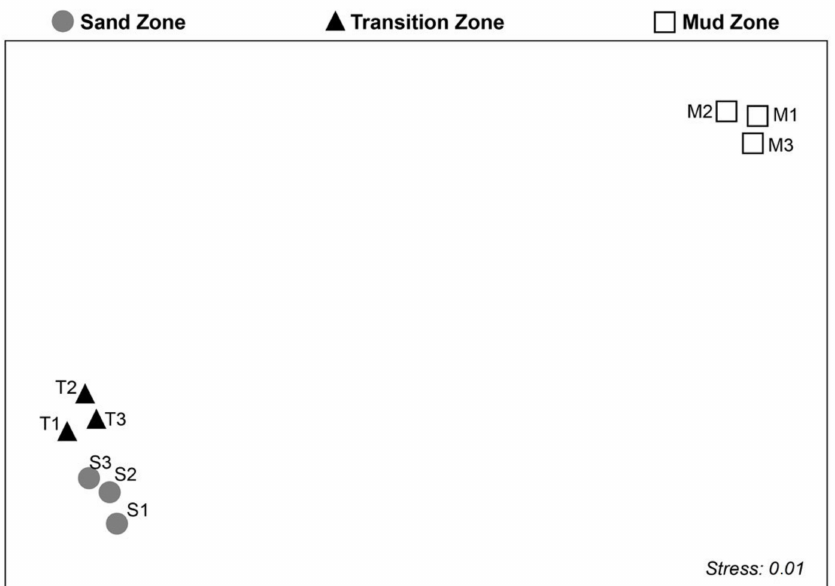
Figure 2. Non-metric Multidimensional Scaling (nMDS) showing the di ff erences among the composition of macroinfaunal communities on the three sampling zones in summer. Numbers after S (Sand Zone), T (transition Zone) and M (Mud Zone) represent the van Veen grab replicate (n = 3) of each